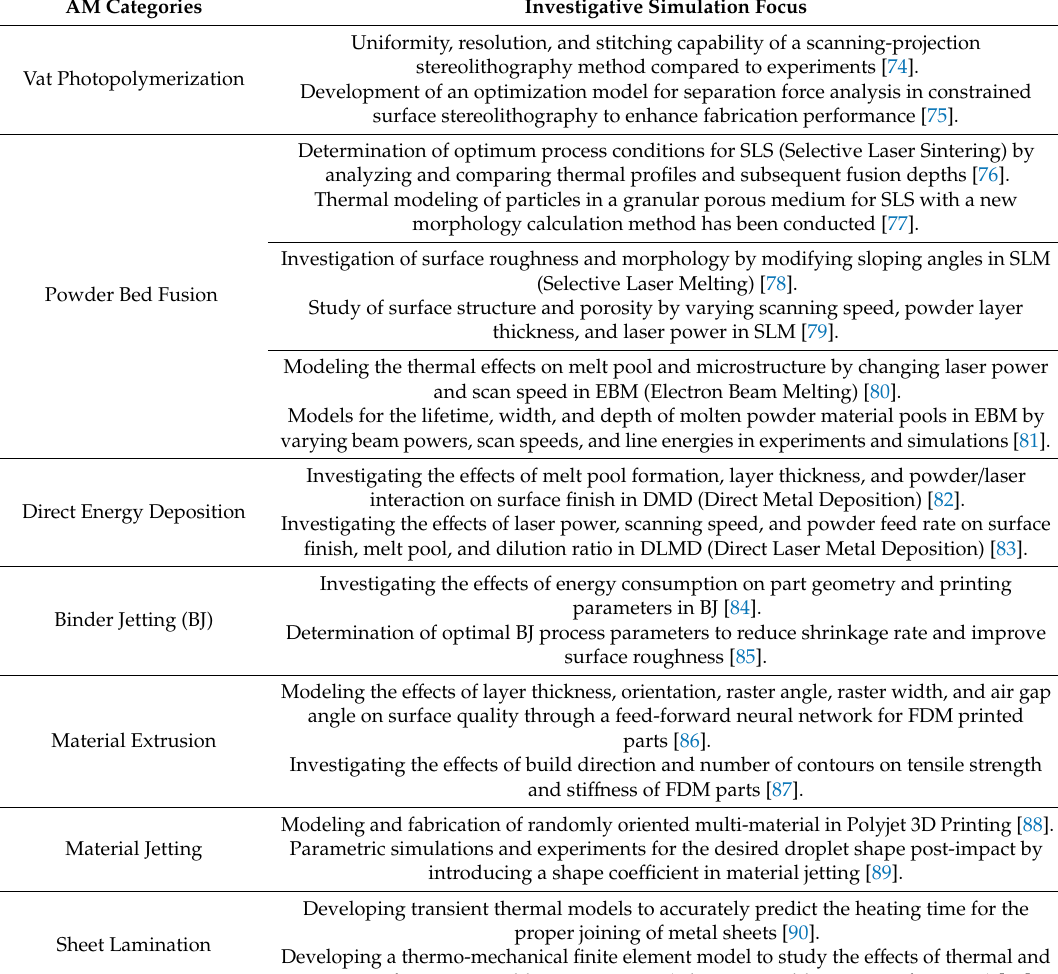
Table 1. Modelling studies based on additive manufacturing (AM)